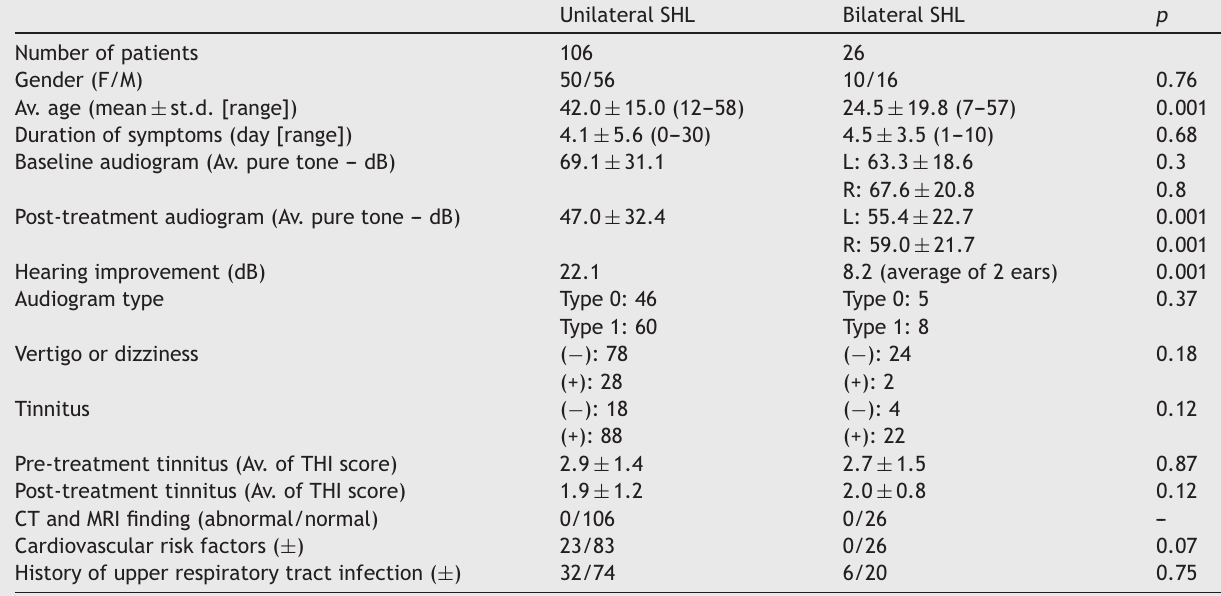
Demographics, clinical findings, tinnitus scores and audiologic data of the patients with unilateral and bilateral SHL ( p -values are statistics between the groups). Unilateral SHL Bilateral SHL p Number of patients